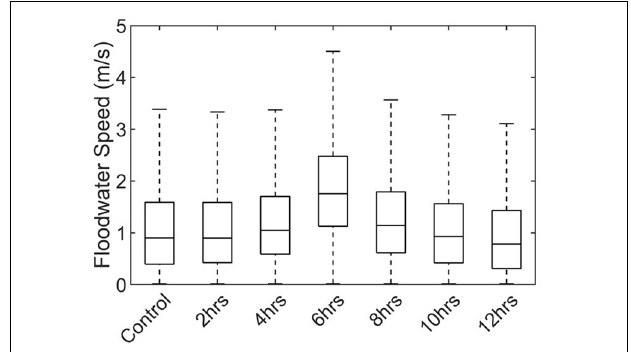
Modeled spatial distribution of coastal flooding ( Figure 7 ) illustrates a wider extent of flooding in neighborhoods on the east side of Manhattan along the East River. The flood depth is larger in the southern and eastern sides of the study area and locally surpasses 2 m in some neighborhoods. The results are consistent with previous studies (e.g., Yin et al.,